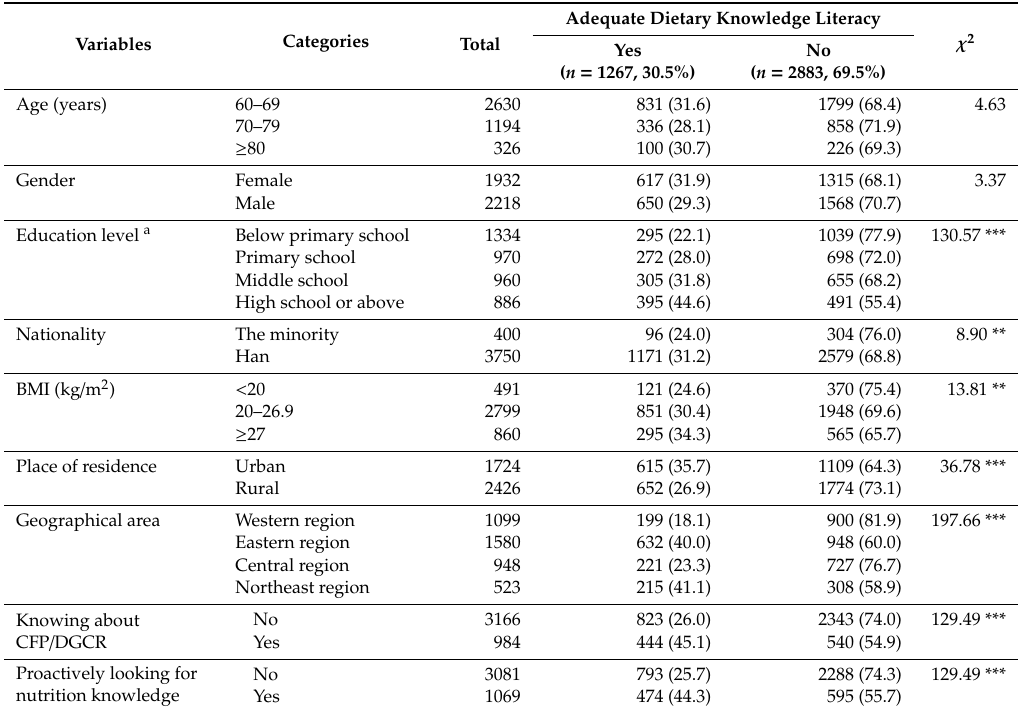
Table 3. The dietary knowledge literacy of participants with different demographic characteristics in 2015.